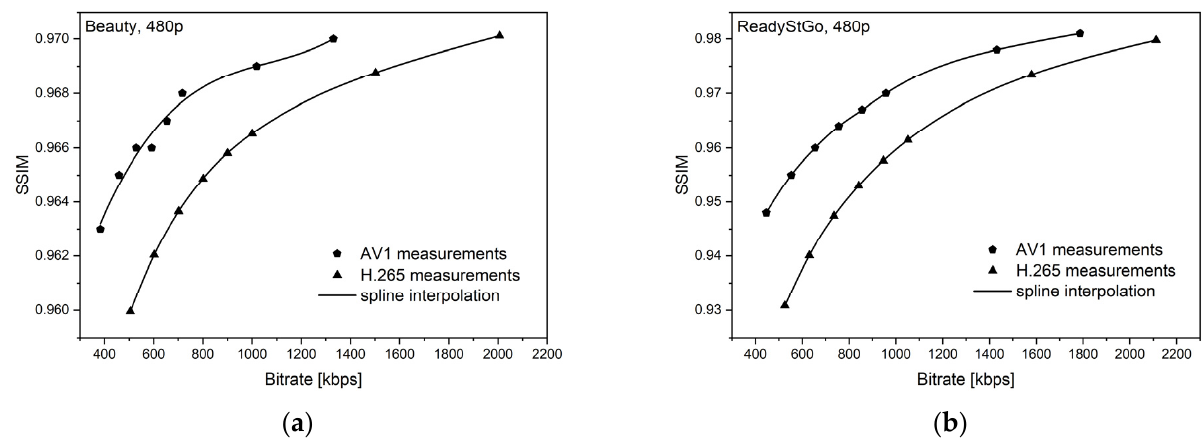
Figure 11. Comparison of the H.265 and AV1 codecs, based on the SSIM metric, for two different videos: ( a ) slow motion video; ( b ) fast motion video.